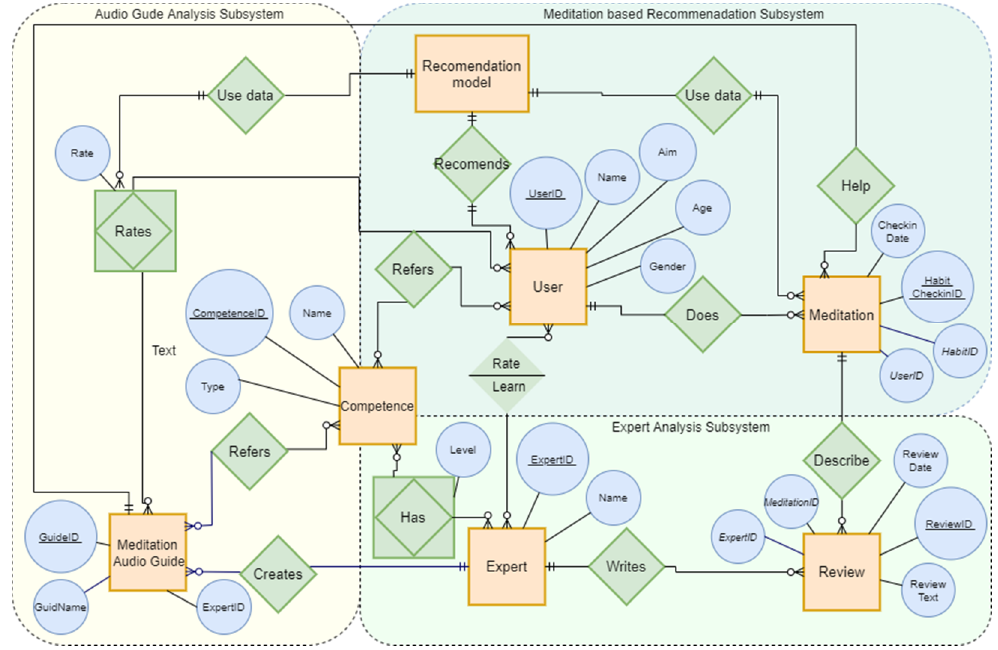
Figure 21. Reference model for competence management of conscious exercise coaches.